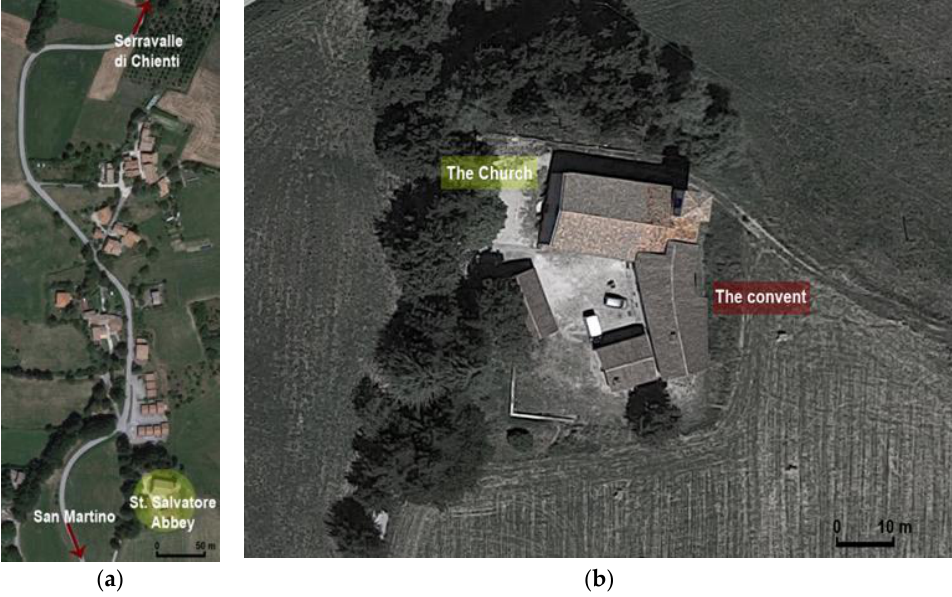
Figure 2. Aerial views. ( a ) The location of St. Salvatore Abbey in Acquapagana [40]; ( b ) the complex of St. Salvatore Abbey: the church (in the north) and the monastery building (in the east). Coordinates: 42°59′00.5′′ N 12°55′49.2′′ E [40].